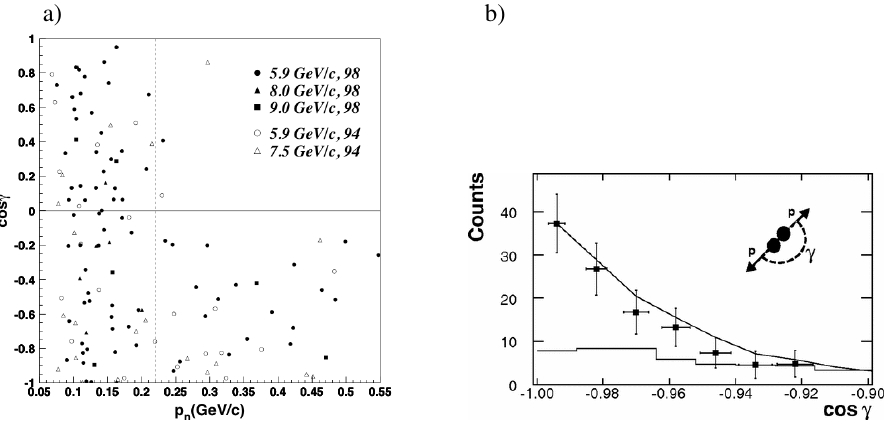
Figure 2. Distribution of the relative angle ( γ ) between the reconstructed initial momentum of the knockout proton and the recoil neutron as a function of the recoil neutron momentum p n (a). The vertical dashed line at k F = 225 MeV / c marks the border between the regions with isotropic ( p n < k F ) and correlated ( p n > k F ) distributions. (b) projection on cos( γ ) axis for scattering o ff ∼ 500 MeV / c initial momentum protons. Pictures are adapted from [2,